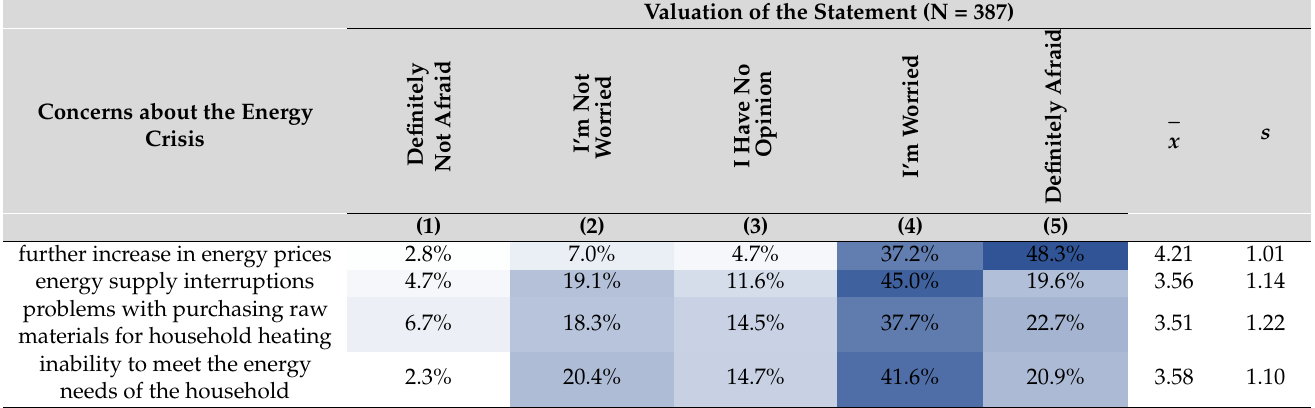
Table 6. Assessment of concerns about the energy crisis — response structure and basic statistical parameters.